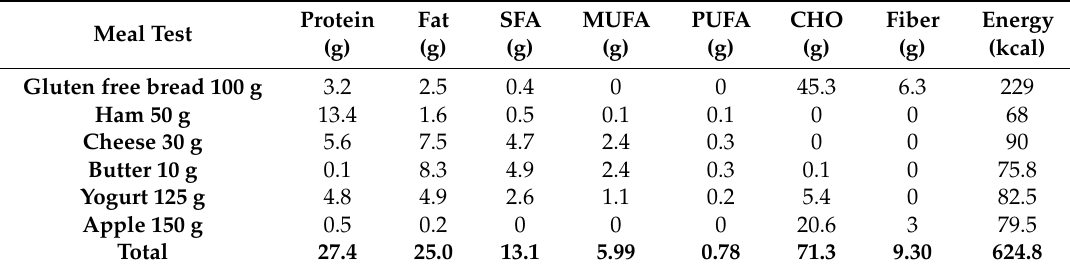
Table 1. Nutritional composition of the meal